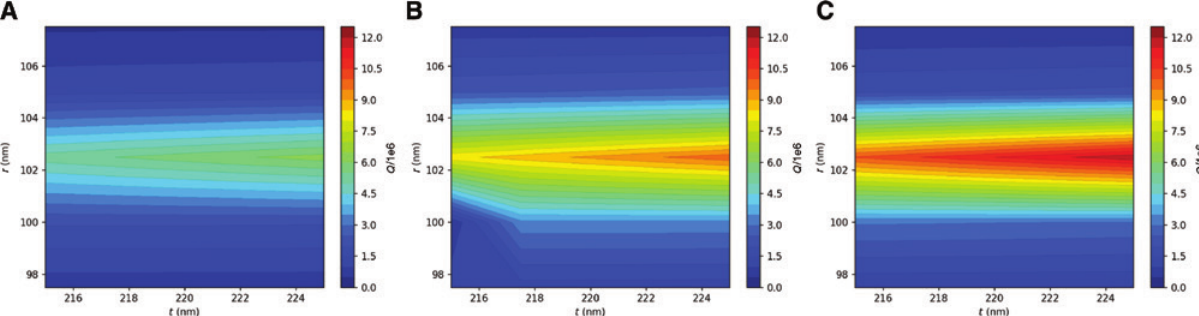
Figure 9: The influences of changes in the air hole radii r and the slab thickness t on the Q factors. The results for the cavity designs optimized by the strategies A, A + B, and A + C, are shown in (A), (B) and (C), respectively. The values employed in Section 3 are r = 102.5 nm and t = 220